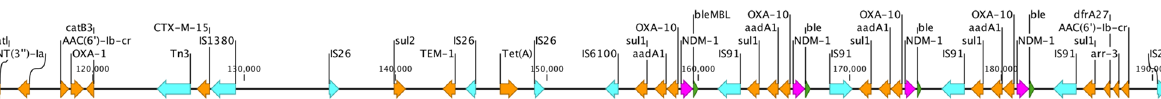
Figure 5. NDM repeat without inverted repeat (IR) in plasmid of NDM-1-positive eco286